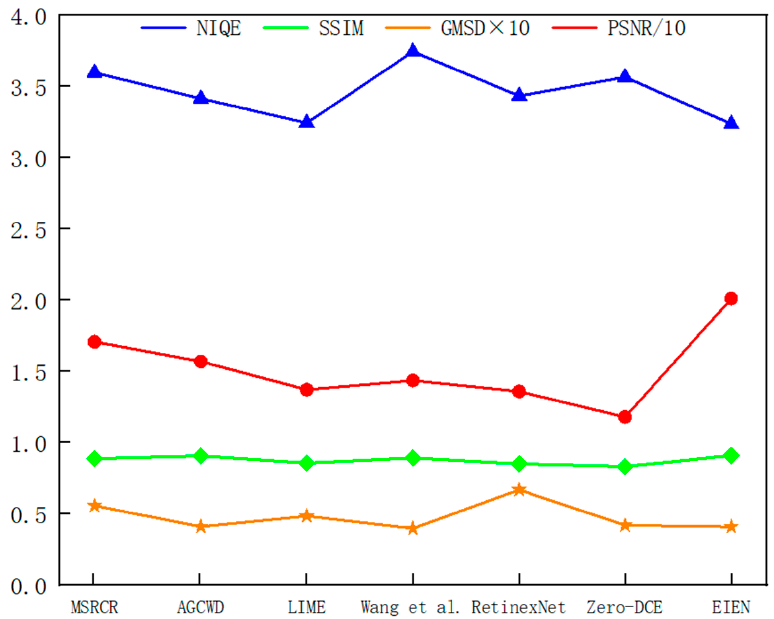
Figure 10. Average index comparison chart. The value of PSNR to 1/10 of the original value, and the value of GMSD to 10 times the original value. Table 1. NIQE results for different algorithms. The best result is in red whereas the second best one is in blue.